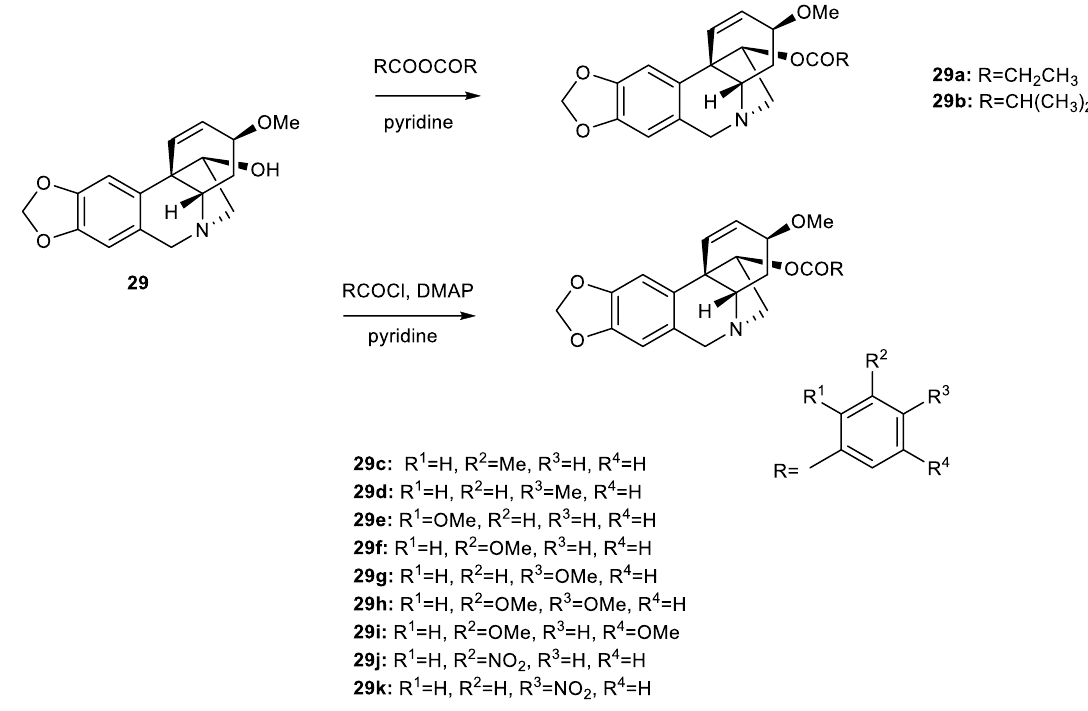
Figure 3 . Overview of tested aliphatic and aromatic esters of haemanthamine ( 29 ) . Figure 3. Overview of tested aliphatic and aromatic esters of haemanthamine ( 29